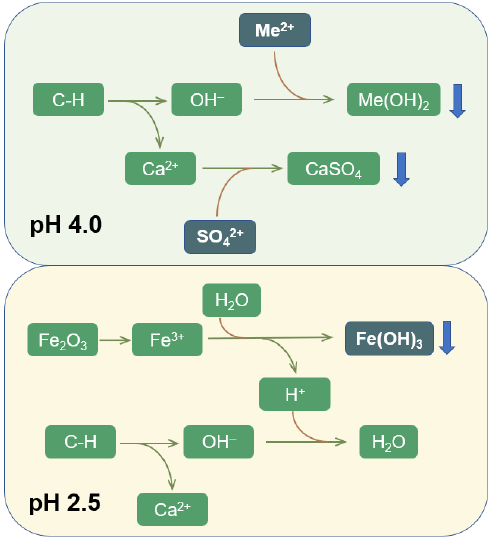
Figure 8. The mechanisms for removing heavy metals by RMPC from acid mine drainage (Me 2+ : Mn 2+ , Zn 2+ , Cu 2+ and Cd 2+ ). Mn 2+ , Zn 2+ , Cu 2+ and Cd 2+